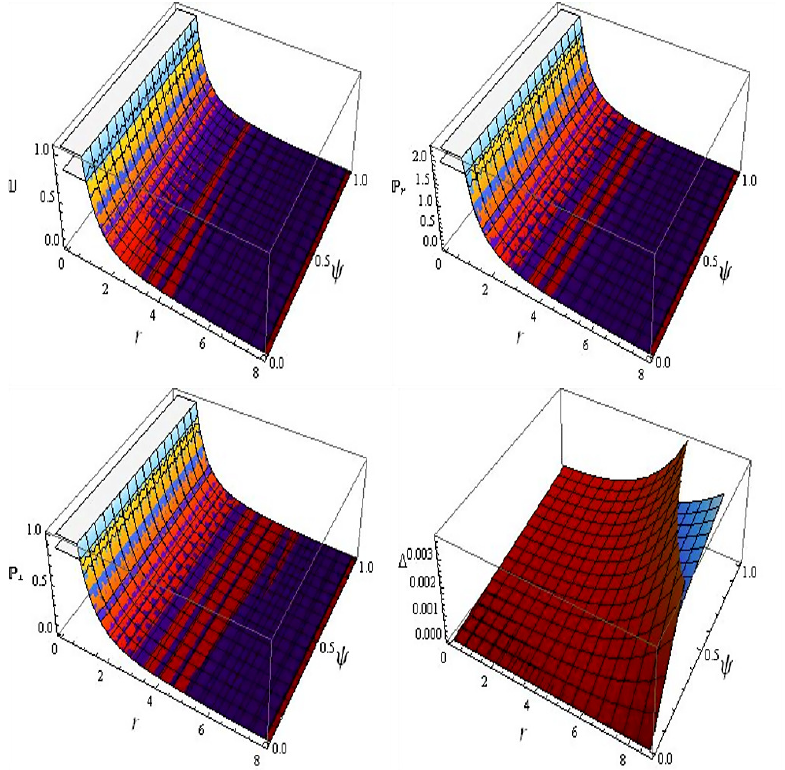
Figure 4. Physical analysis of U , P r , P ⊥ and (cid:52) versus ψ and r corresponding to two stellar candidates (Solution